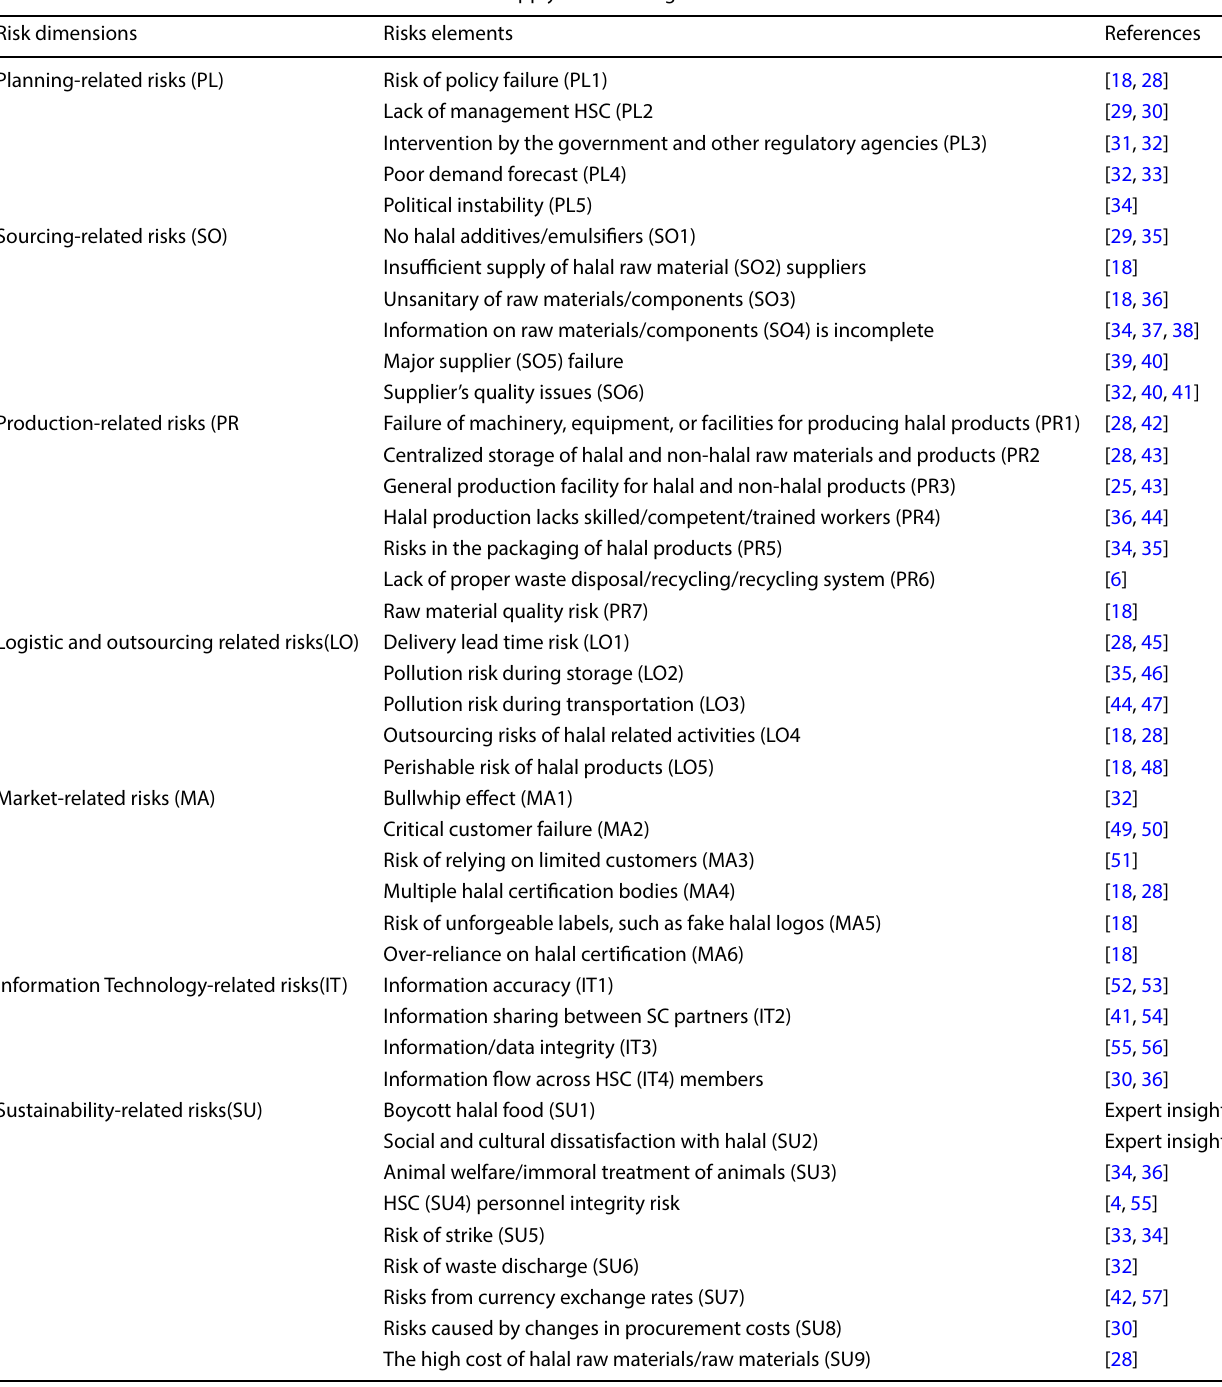
Table 1 Risk dimensions related to risk elements of Halal supply chain management Risk